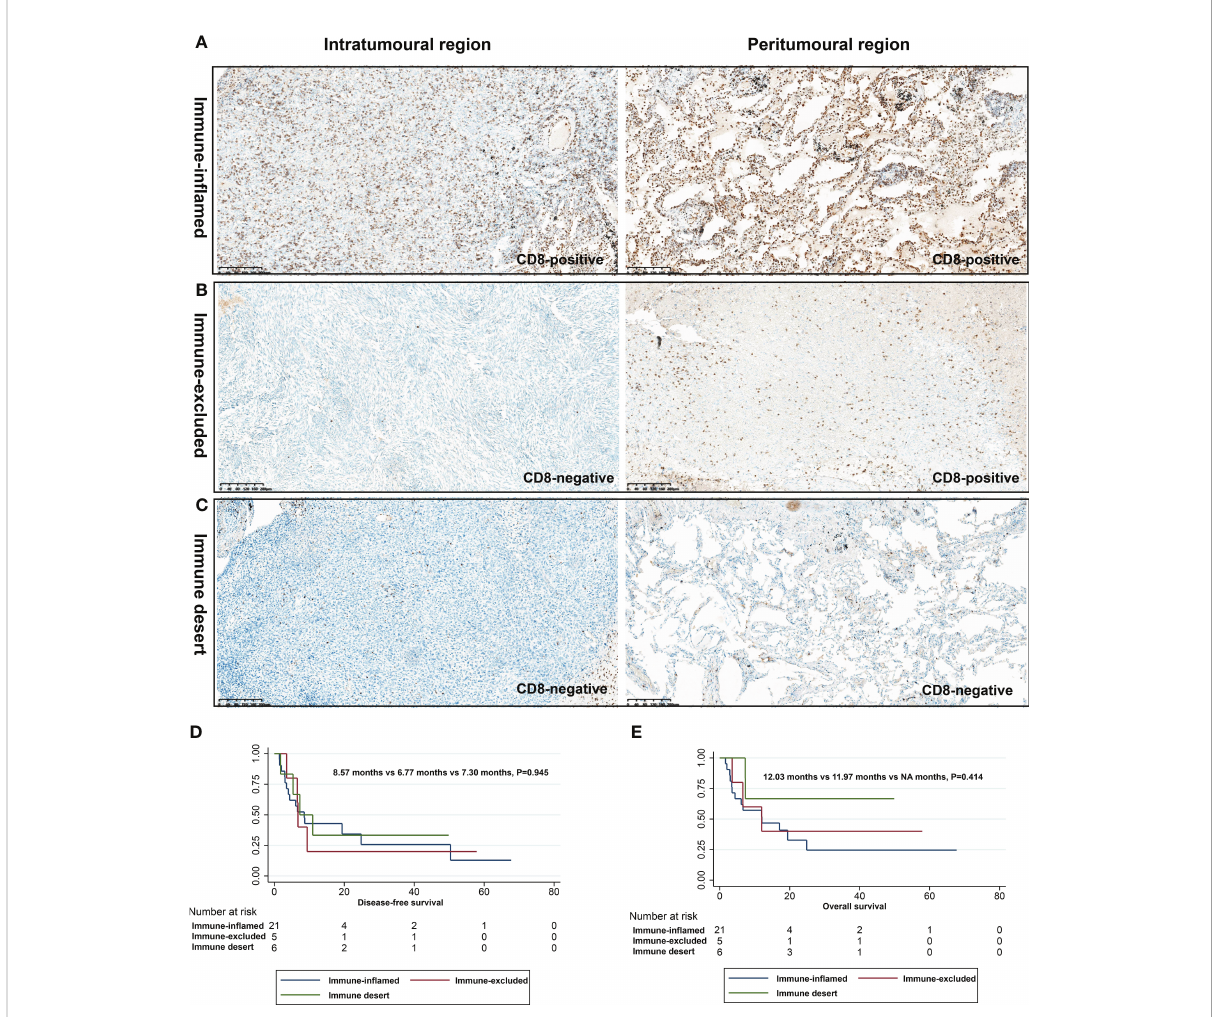
FIGURE 5 Immunophenotyping based on CD8+ T cell in fi ltration in different spatial regions. Immune in fl amed type (A) , immune excluded type (B) , and immune desert type (C) ; DFS (D) and OS (E) of different